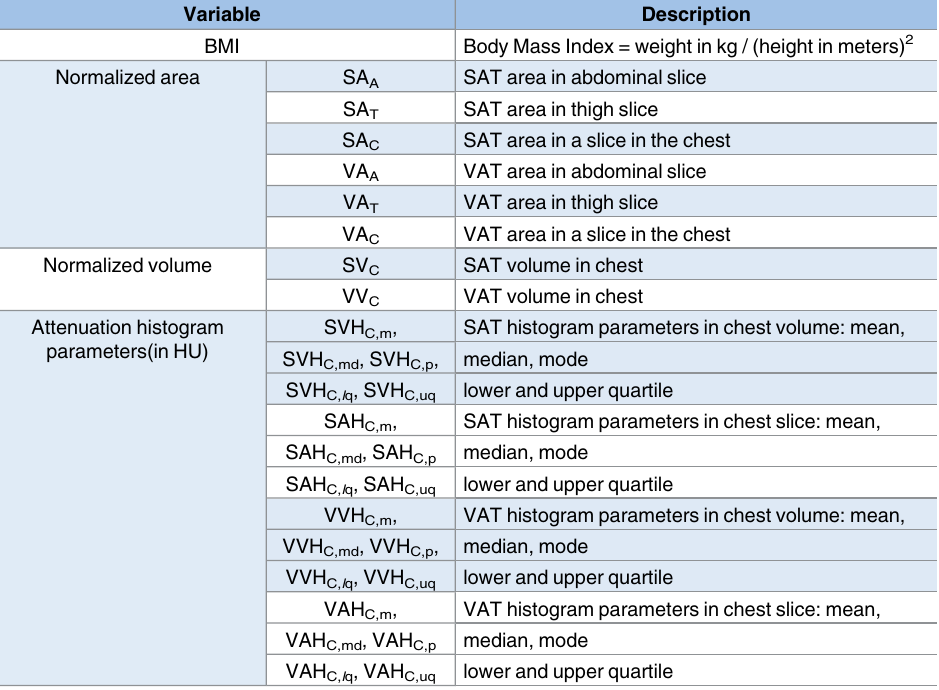
Table 2. Definition of variables employed in correlative